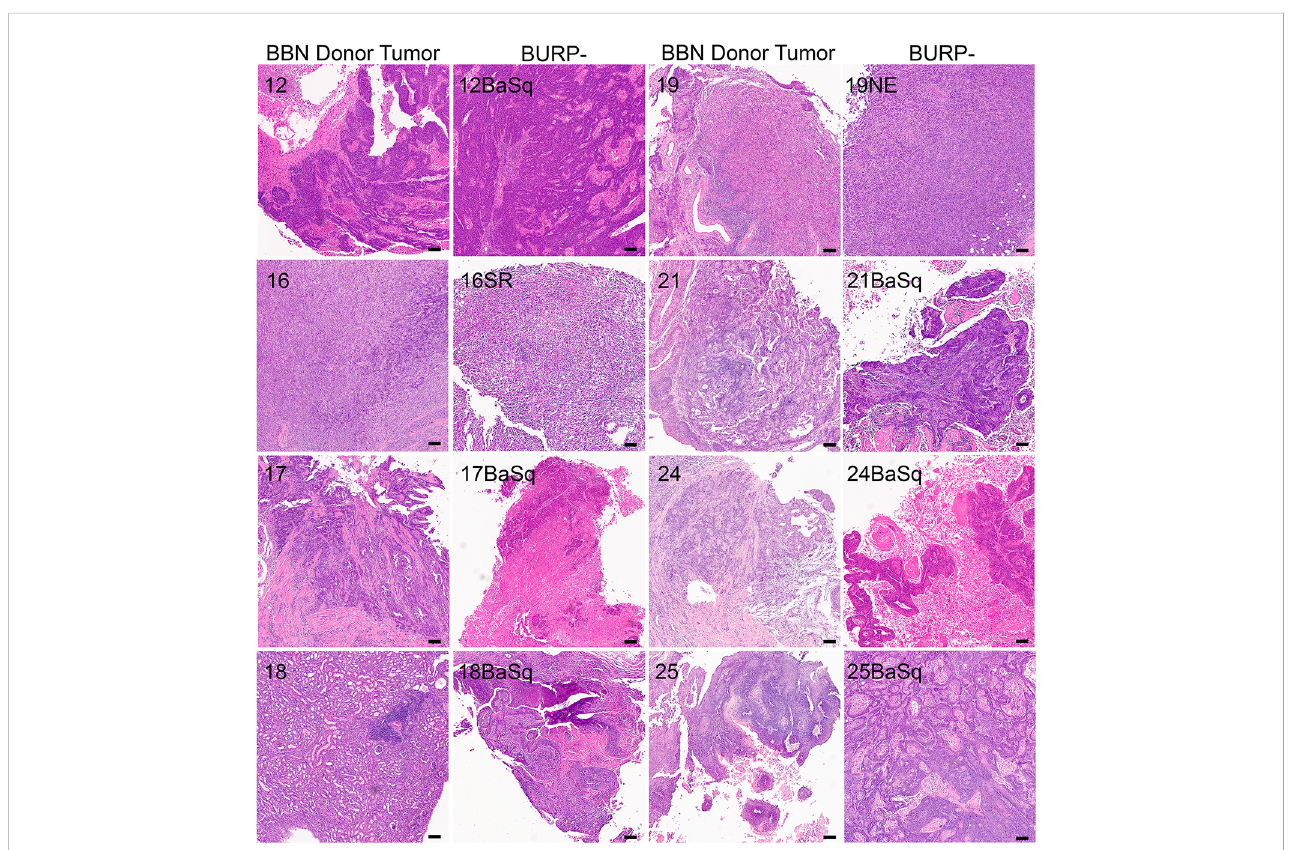
FIGURE 2 Generation of histologically diverse BURP tumor lines. H&E of original high-grade muscle-invasive tumors (BBN Donor Tumor) in male and female C57BL/6 mice exposed to 0.1% BBN. Representative H&E from each established BURP tumor lines from each original BBN Donor Tumor, Scale bar is 100µm.